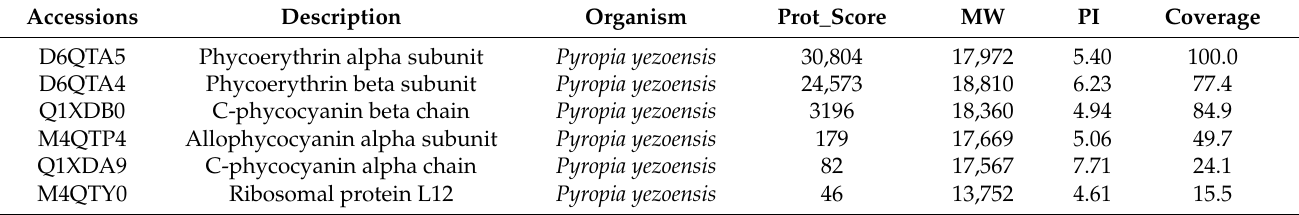
Table 2. Mascot search